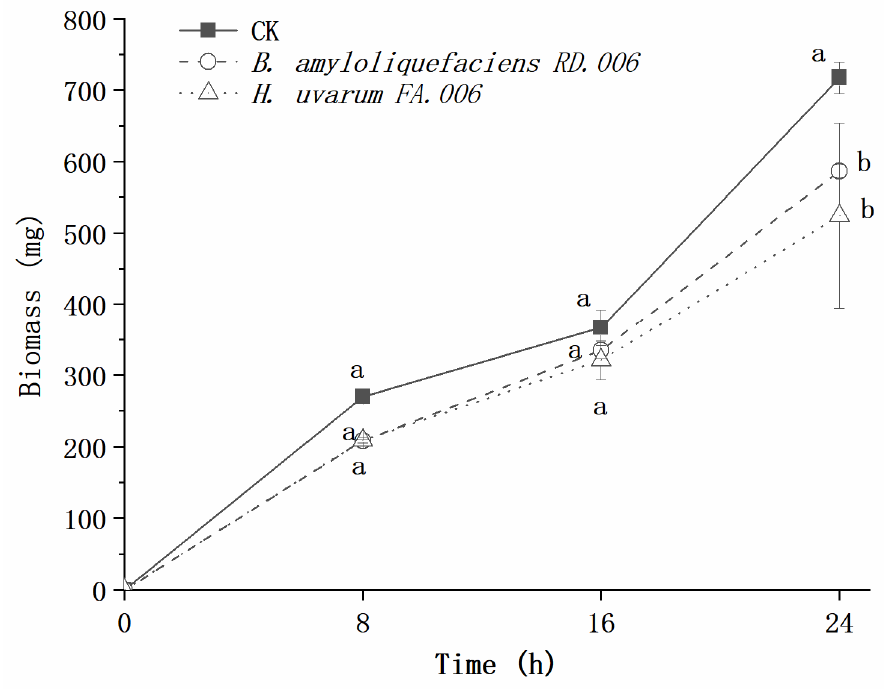
Figure 5. Inhibitory effects of a biocontrol agent at 10% concentration on the growth of Bot. dothidea JNHT01. Error bars represent standard deviations from the mean. a–b: different letters at the same time indicate significant differences with a p < 0.05.